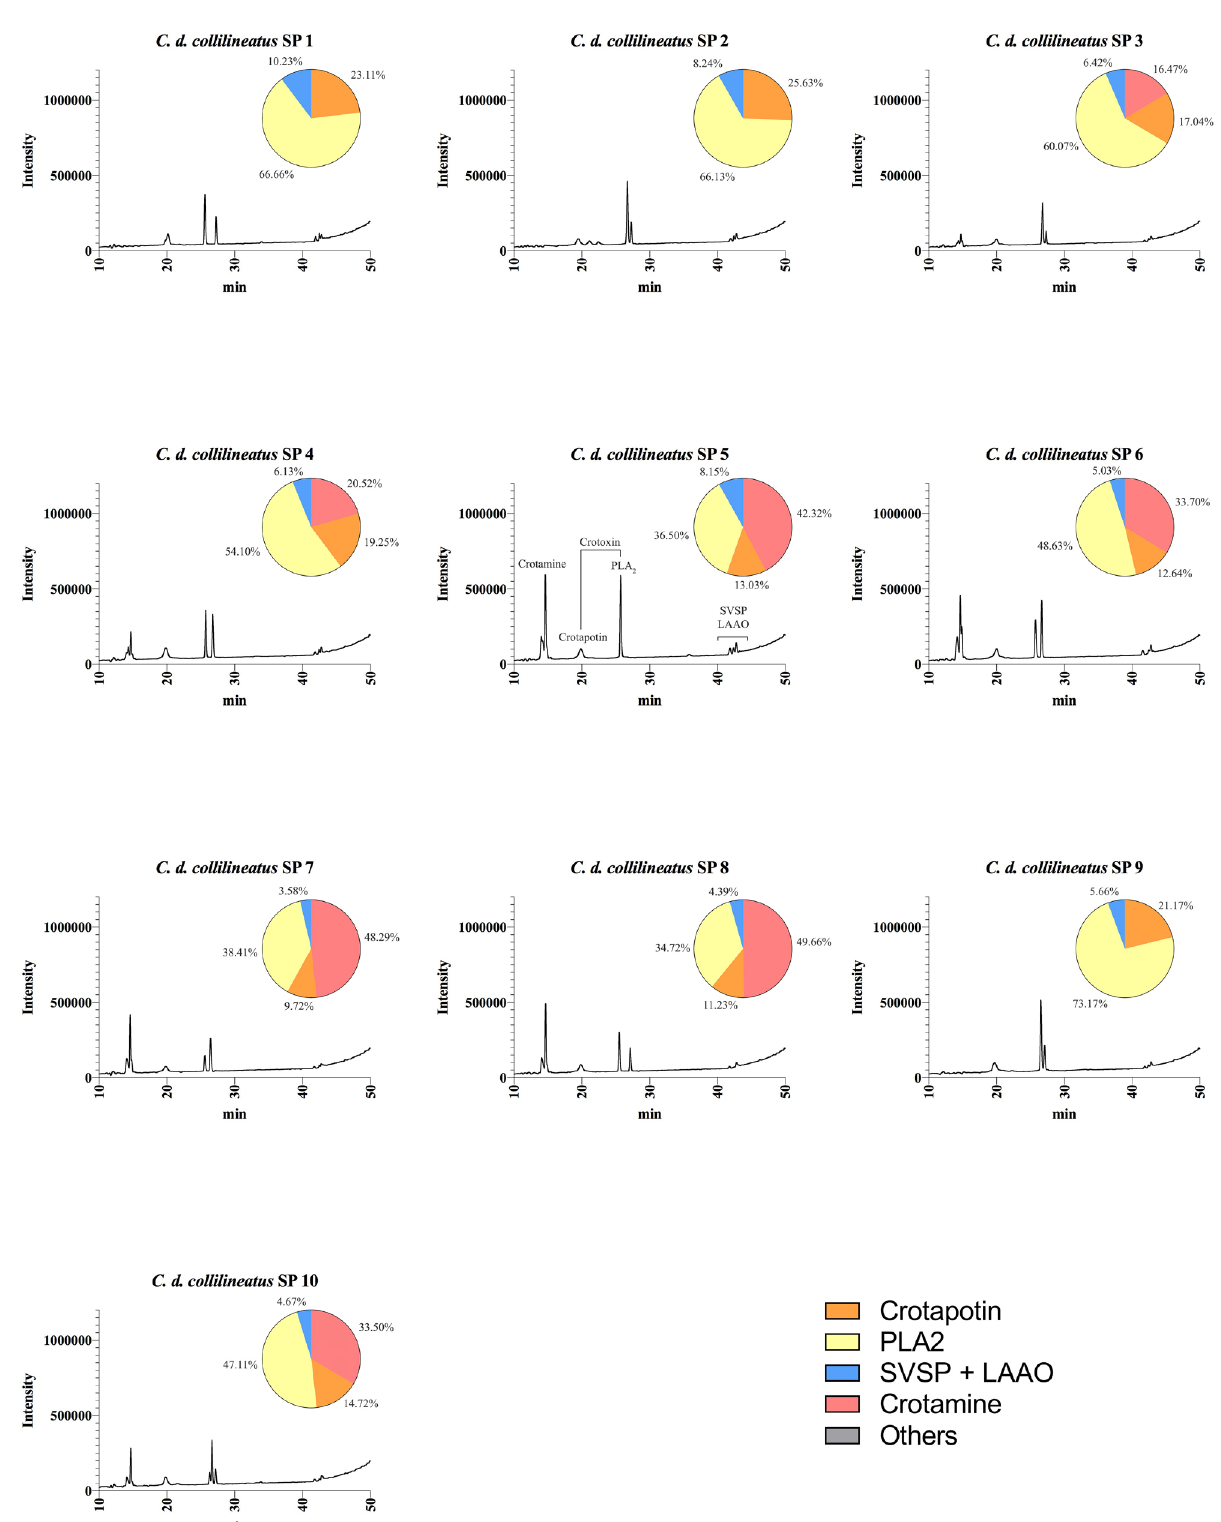
Figure 5. Elution profiles of individual C. d. collilineatus venom from São Paulo state by RP-HPLC. Samples of 25 μg of lyophilized venom were dissolved in 0.1% trifluoroacetic acid (TFA) and 5% acetonitrile (solution A) and subjected to RP-HPLC on a C18 column. Elution was performed at 1.0 mL/min by applying a gradient toward 0.1% TFA and 95% acetonitrile (solution B), as described in the experimental section. The main chromatographic peaks of one representative were assigned to its major components. This representative was selected based on the presence/absence and intensity of particular chromatographic peaks. LAAO: L-amino acid oxidases; SVSP: snake venom serine proteases, PLA : phospholipases A 2 2